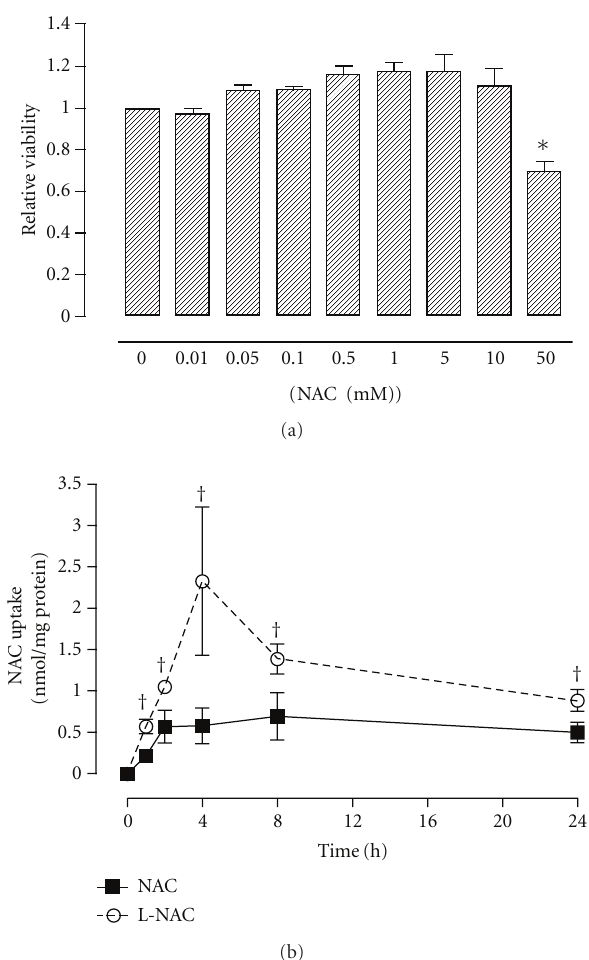
Figure 1: E ff ect of NAC on the cell viability (a) and uptake of NAC (b) in A549 cells. The viability of cells treated for 24 h with increas- ing concentrations of NAC was assessed using the MTT assay. Bars represent mean ± S.E.M. of 3 independent experiments performed in octuplet. ∗ denotes significant di ff erence relative to control ( P < . 05). For the uptake studies (b), cells were treated with either 5.0mM NAC- or L-NAC-containing media for various time-points up to 24 h; intracellular NAC levels were measured with a UPLC method as described in Section 2. (solid line: NAC treatment; dot- ted line: L-NAC treatment). Data points represent mean ± S.E.M. of 3 independent experiments performed in duplicate. † denotes significant di ff erence relative to NAC-treated group ( P < . 05).